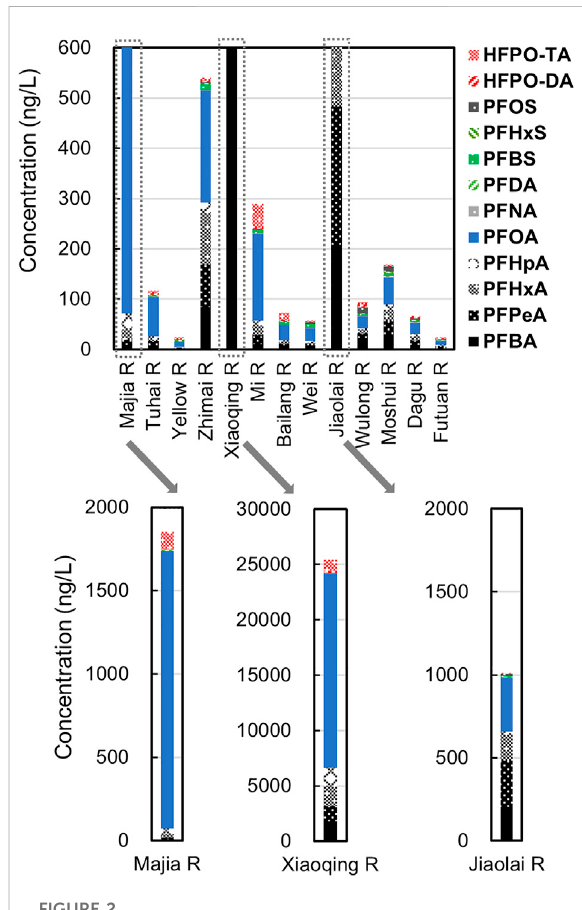
FIGURE 2 Mean concentrations of 12 target PFAS in the coastal rivers (from north coast to the south coast) of Shandong,